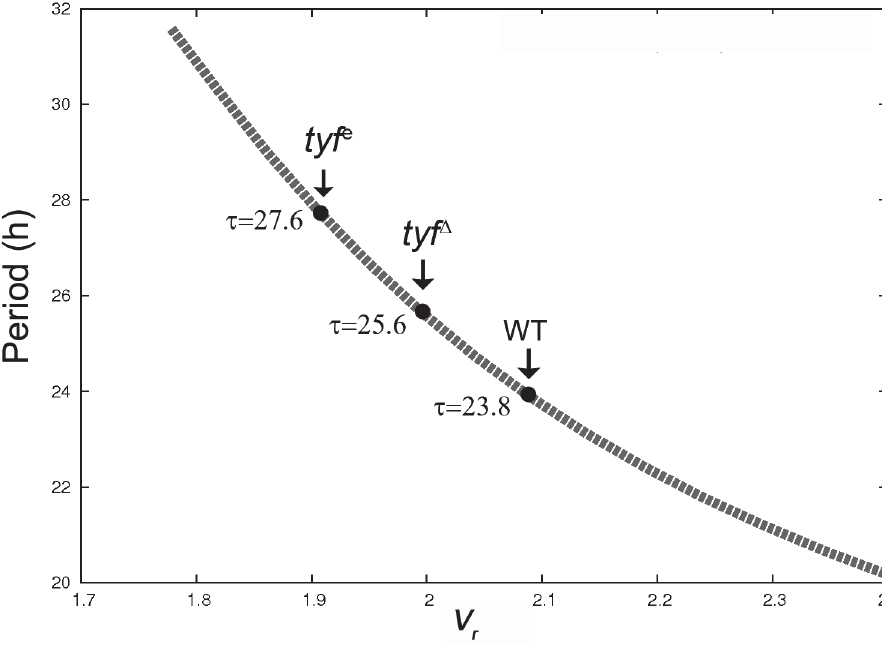
Figure 7. Comparison between theoretical and experimental results. The dashed gray line shows the dependence of τ with the V r parameter obtained with our model, for k s = 0 h − 1 , K r = 0.3 nM h − 1 and nH = 4 . The periods of behavioral rhythms in wild type (WT) flies and tyf mutants ( tyf e and tyf Δ ) are also indicated with black points and arrows, according to [25]. See the text for further details